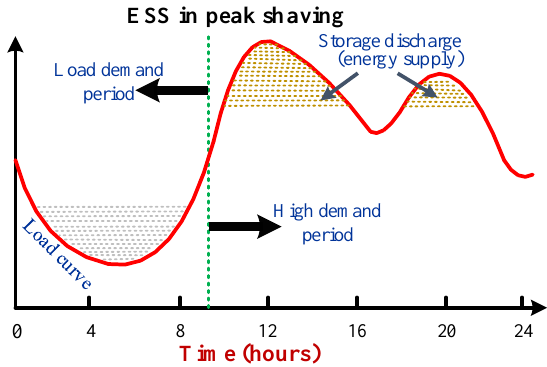
Figure 13. The load profile of energy storage used in peak shaving.